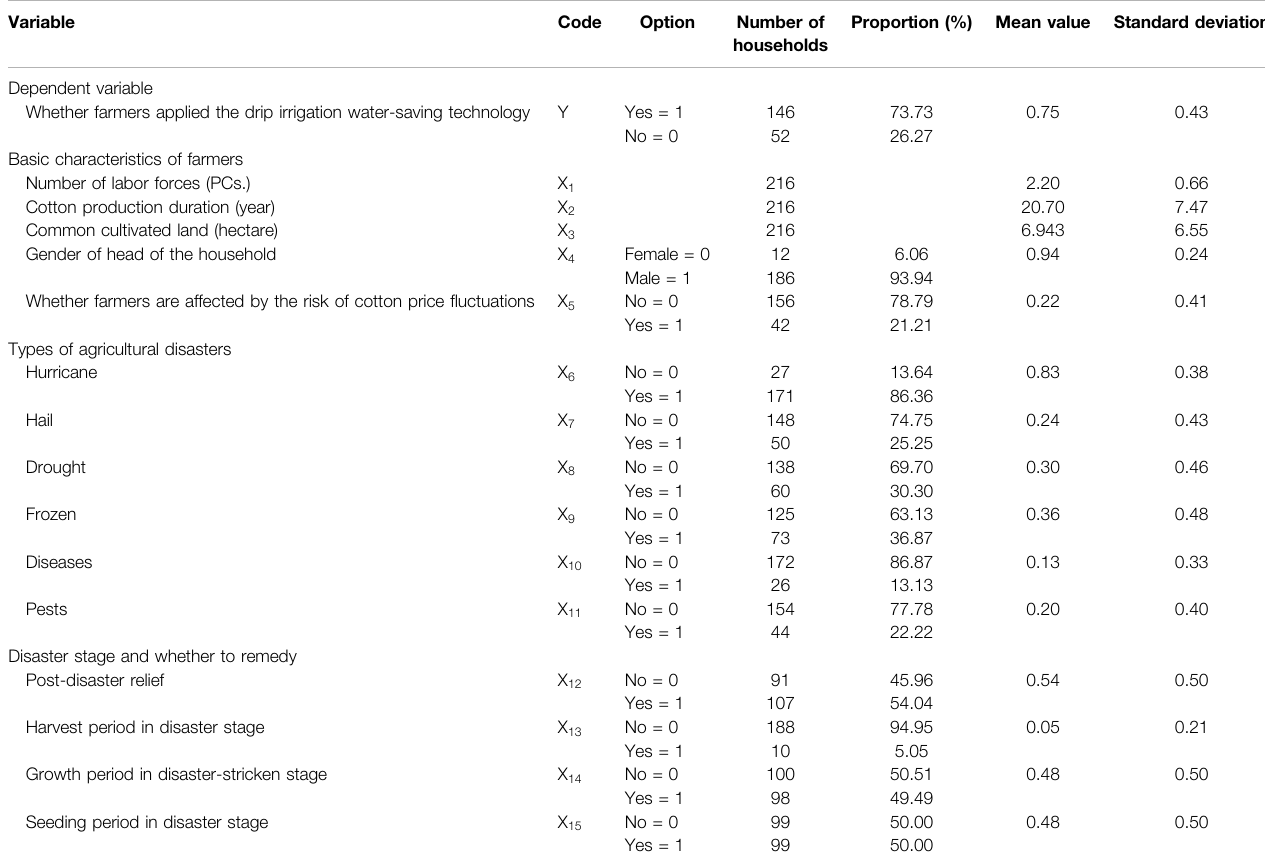
TABLE 3 | Selection and treatment of explanatory variables of the model.